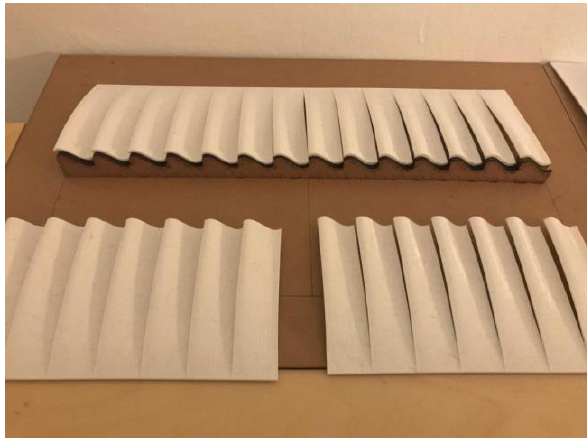
Figure 13: intermediate supports were laser-cut in order to visualize the whole roof surface on a mdf base.